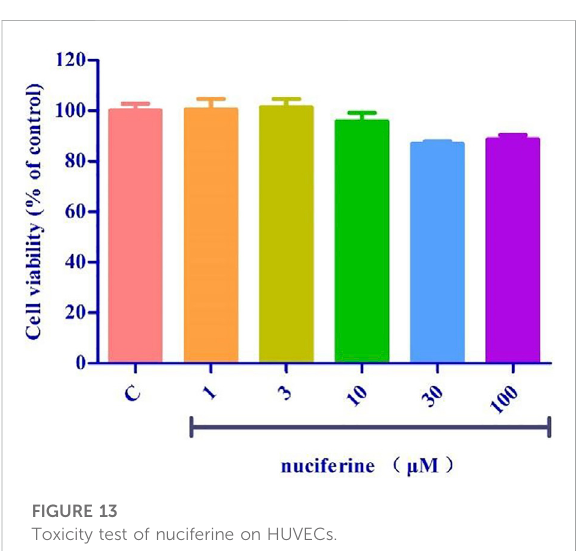
FIGURE 13 Toxicity test of nuciferine on